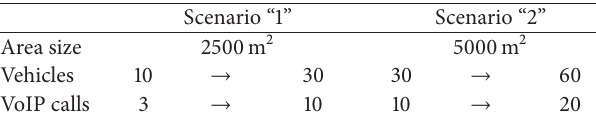
Table 1: MANET simulation scenarios.